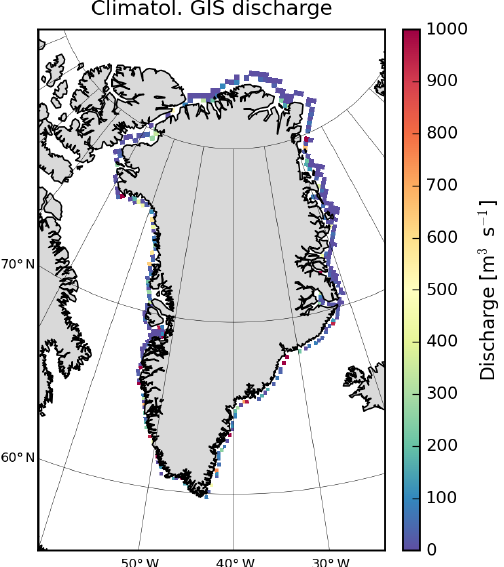
Figure 2. Spatial distribution of annual mean GIS discharge fol- lowing the climatologies by Bamber et al. (2012) and Martin et al. (2019). The pronounced seasonal cycle is shown in Fig.